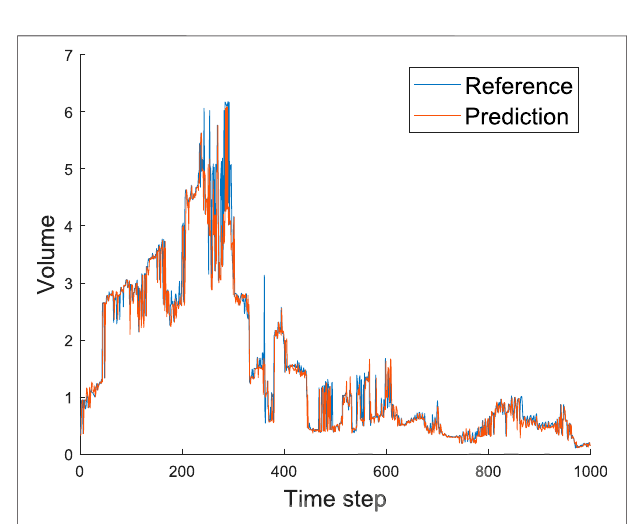
FIGURE 9 | Predicted and reference volume (scaled with h 3 ) of all the structures in the inner region ( y ≤ 0.2) as a function of the time step. Note that the network rarely overestimates this volume.